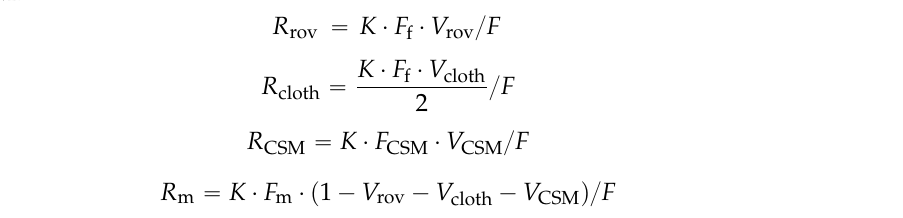
Coupon for in-plane sheartest, 45 °